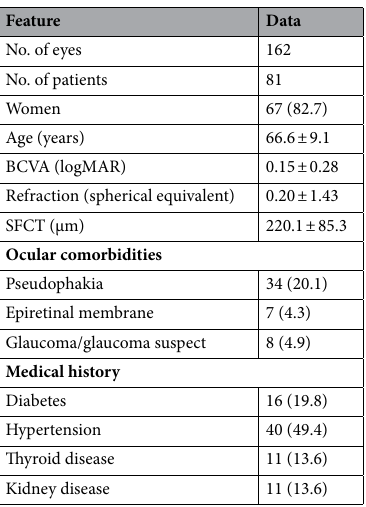
Table 1. Clinical and demographic features. Data are total no. (%) or mean ± standard deviation, unless otherwise indicated. BCVA best-corrected visual acuity, logMAR logarithm of the minimum angle of resolution, SFCT subfoveal choroidal thickness.